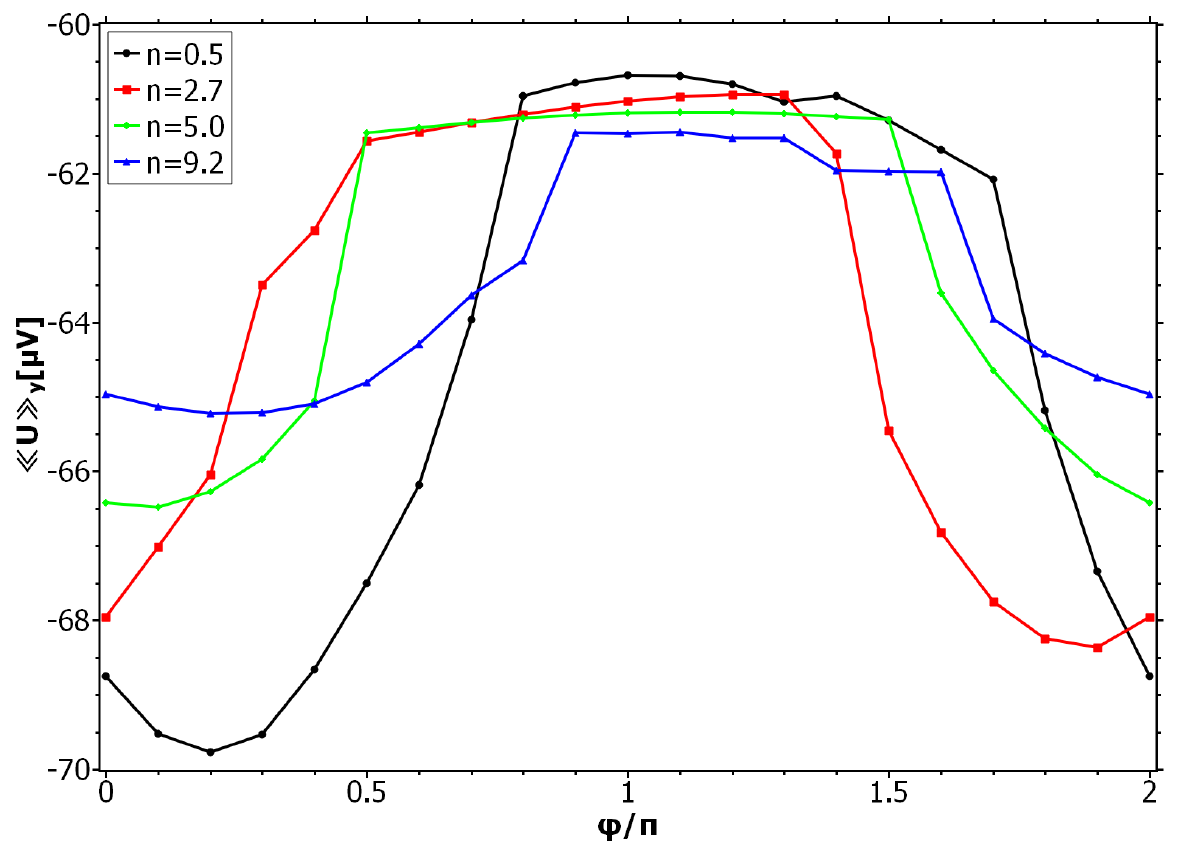
Figure 4. Mean voltage versus phase shift of α s for specific winding numbers. The values of n are chosen such that for ϕ = 0 we are in the resistive state (see Figure 3a). An appropriate phase shift switches the system from being resistive to being